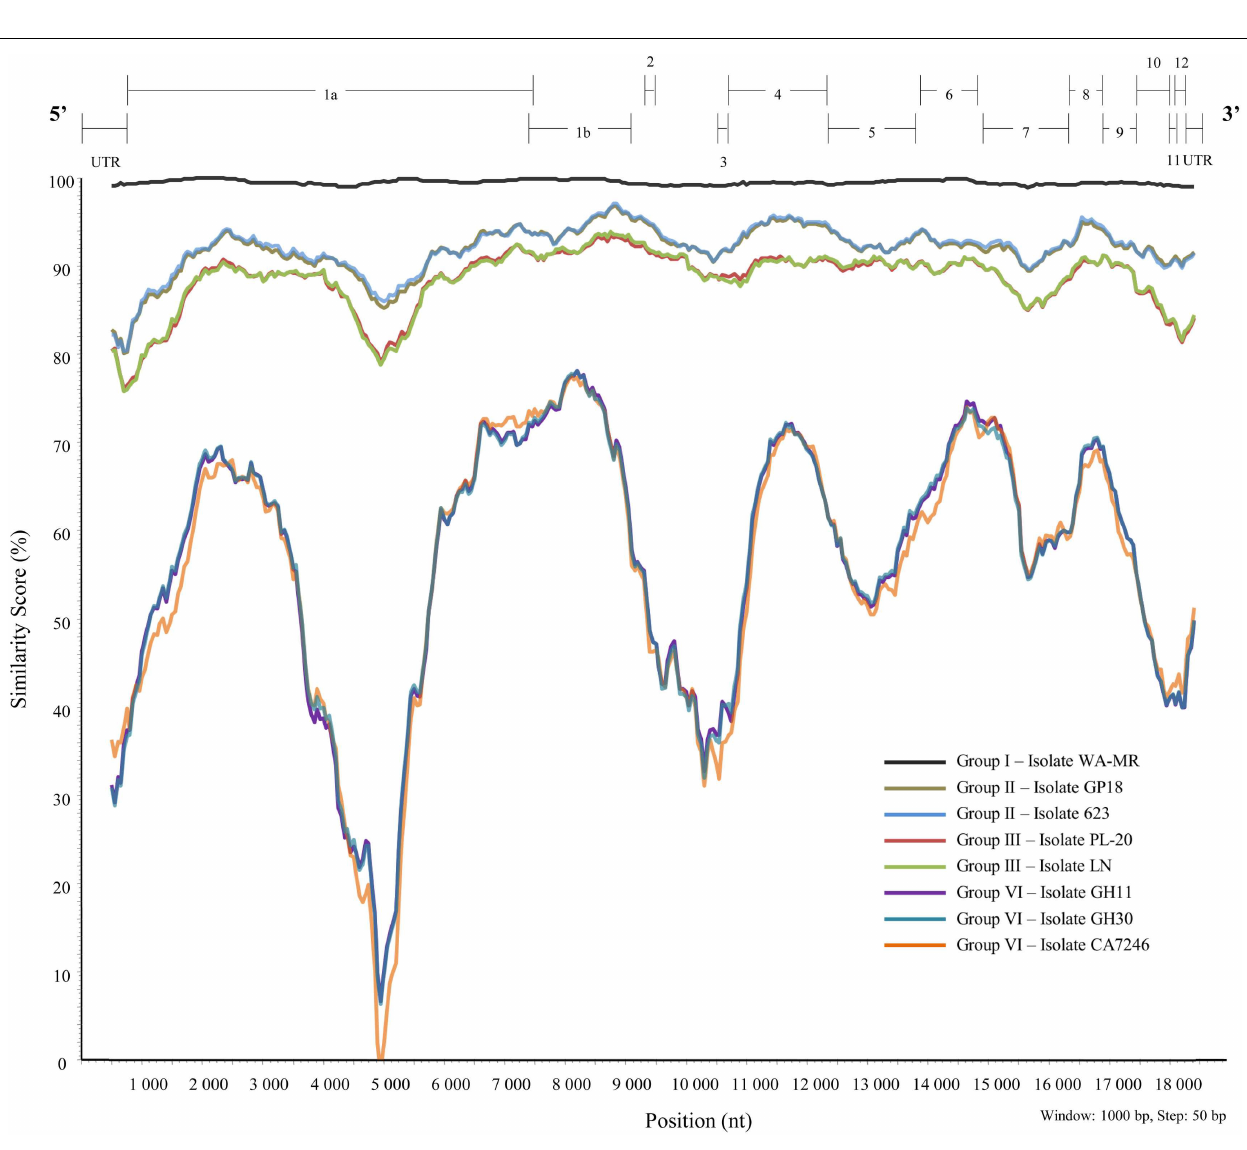
FIGURE 5 | Similarity plot constructed from a multiple alignment of nine full-length sequences representing six well-defined variant groups of GLRaV-3 using SimPlot, PHYLIP (Pylogeny Inference Package) v3.5.1 (Lole et al.,